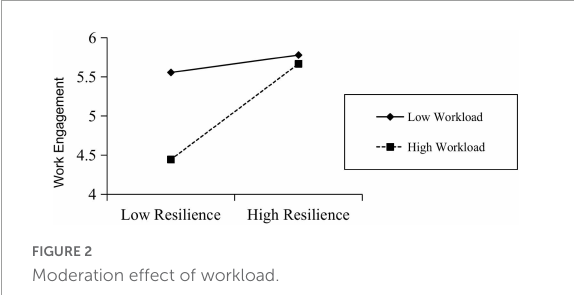
FIGURE2 Moderation effect of